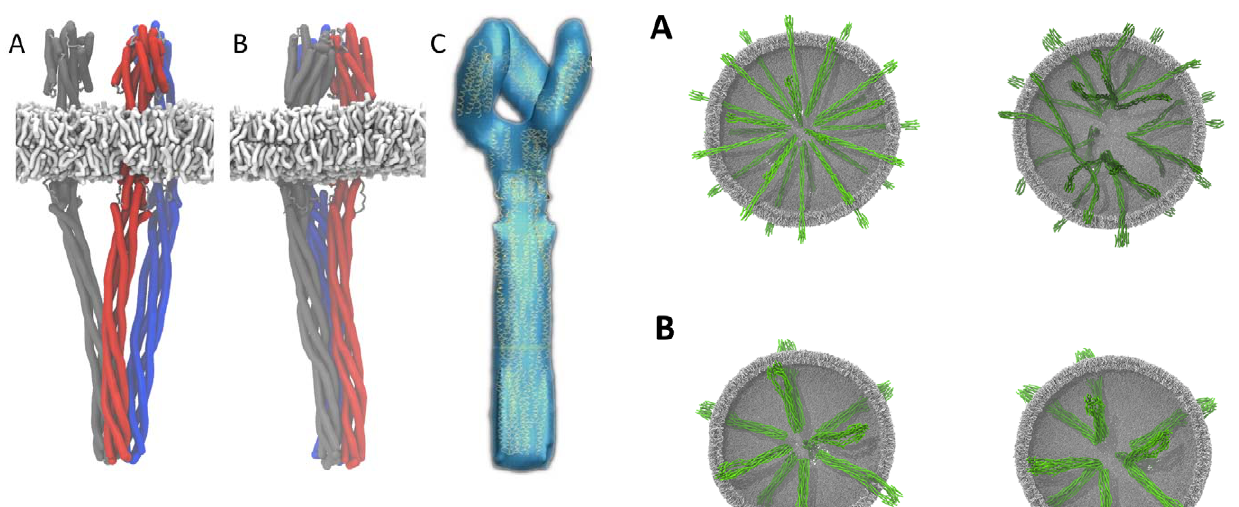
Figure 4. Models of the Tsr trimer of dimers. A Initial trimer-of- dimers model based on a structure exhibiting the modal bending angle derived from simulations of the individual dimers, with the constituent dimers packed together into the trimer using crystal contacts in the coiled coil domain (1QU7). B ‘‘Closed’’ trimer model generated after 0.5 m s MD with restraints on crystal contacts. C Cryoelectron tomography image of the trimer taken from Khursigara et al [7].